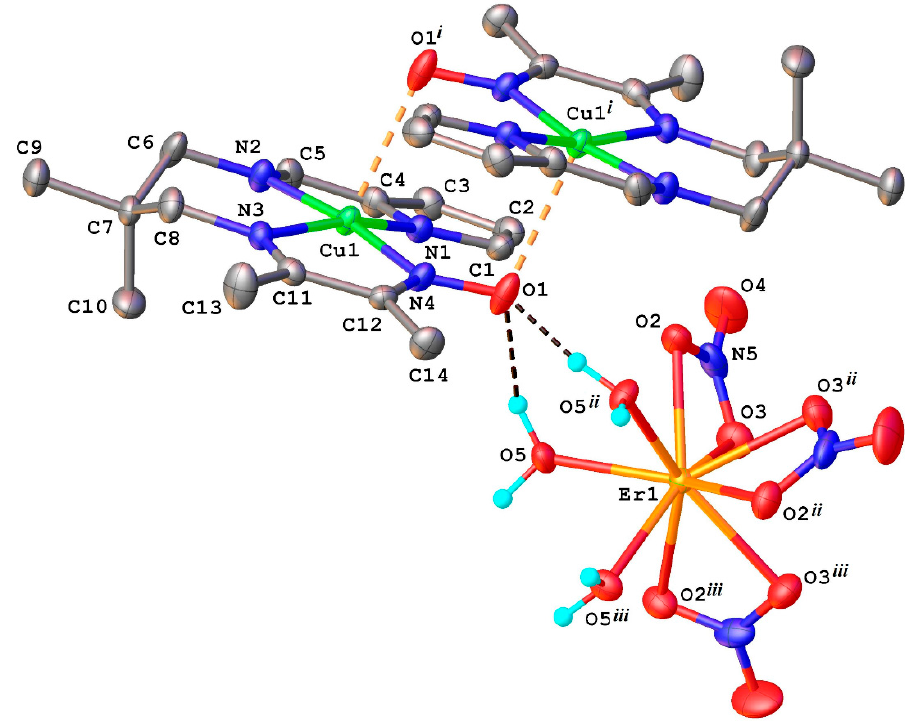
Figure 4. Extended asymmetric unit in the crystal structure of 5 and the environment of the cooper and erbium atoms with atom labelling scheme and thermal ellipsoids at 40% probability level. Non-relevant H-atoms are omitted. Selected bond lengths (Å) and angles (°): Cu–N1 1.954(2), Cu–N2